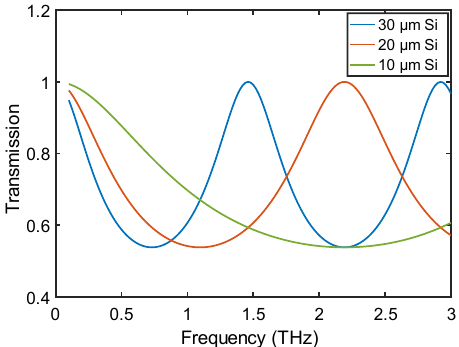
Figure B1. Simulated transmission spectrum of Si thin film with different thicknesses.